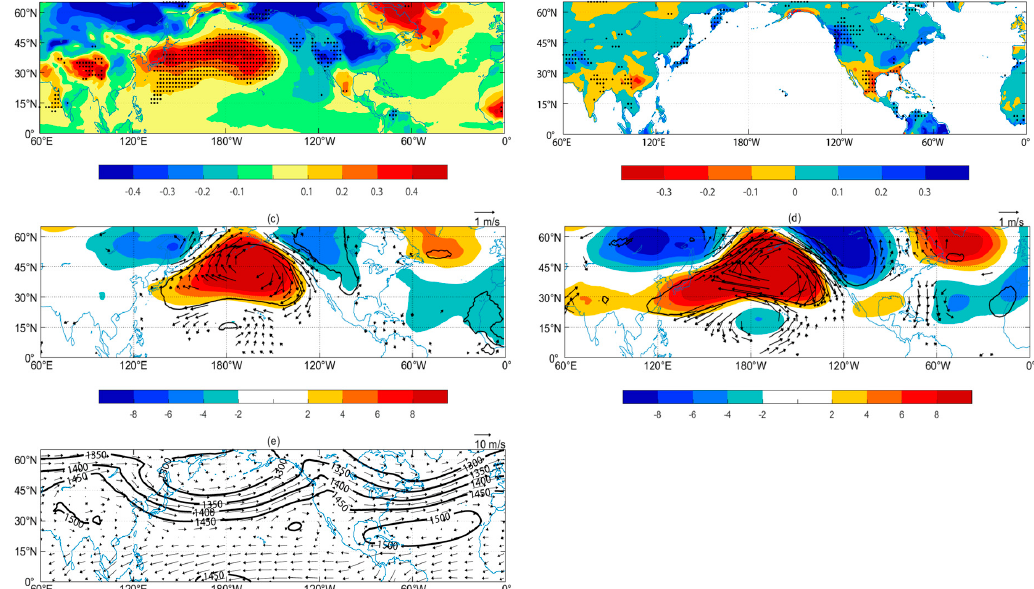
Figure 3. Regressions of the boreal winter; ( a ) 2-meter air temperature ( ◦ C), ( b ) rainfall (mm/day), geopotential height (gpm) and wind (m/s) ( c ) at 850 hPa and ( d ) at 500 hPa onto the NPIMV index. ( e ) Climatological mean geopotential height (gpm) and wind (m/s) at 850 hPa. ( a , b ): Values exceeding 90% for the significance test are dotted. ( c , d ): Winds exceed 90% for the significance test; the black contours indicate the geopotential height exceeding 90% for the significance